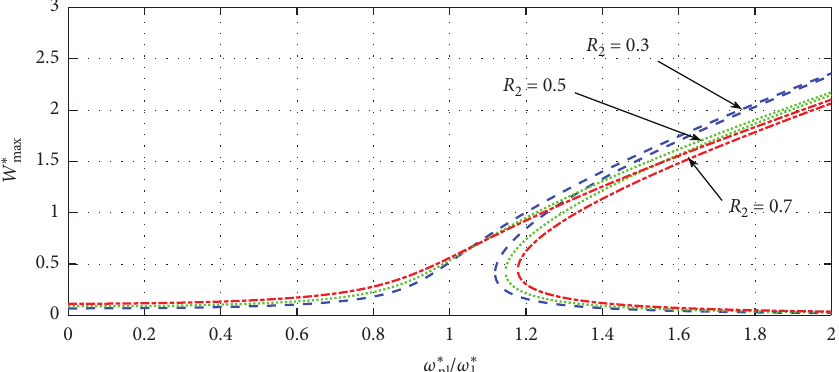
Figure 13: Nonlinear frequency response functions, based on a multimode approach, for beam (b) with different R